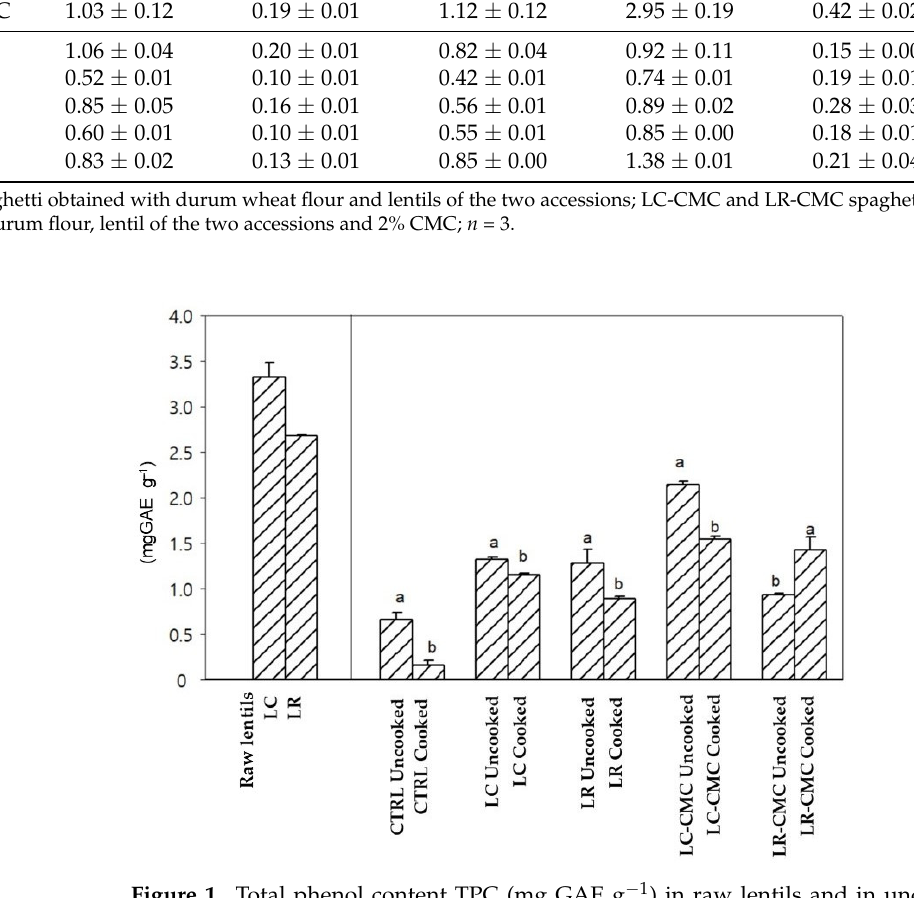
Figure 1. Total phenol content TPC (mg GAE g − 1 ) in raw lentils and in uncooked and cooked spaghetti samples with and without lentils of the two accessions, LC and LR; LC-CMC and LR-CMC fortified spaghetti with 2% CMC; n = 3. Different letters indicate differences between the two lentil accessions and between uncooked and cooked spaghetti within the same sample. LC, Lentil flour; LR, Ragusa lentil flour; CMC, carboxymethyl cellulose.